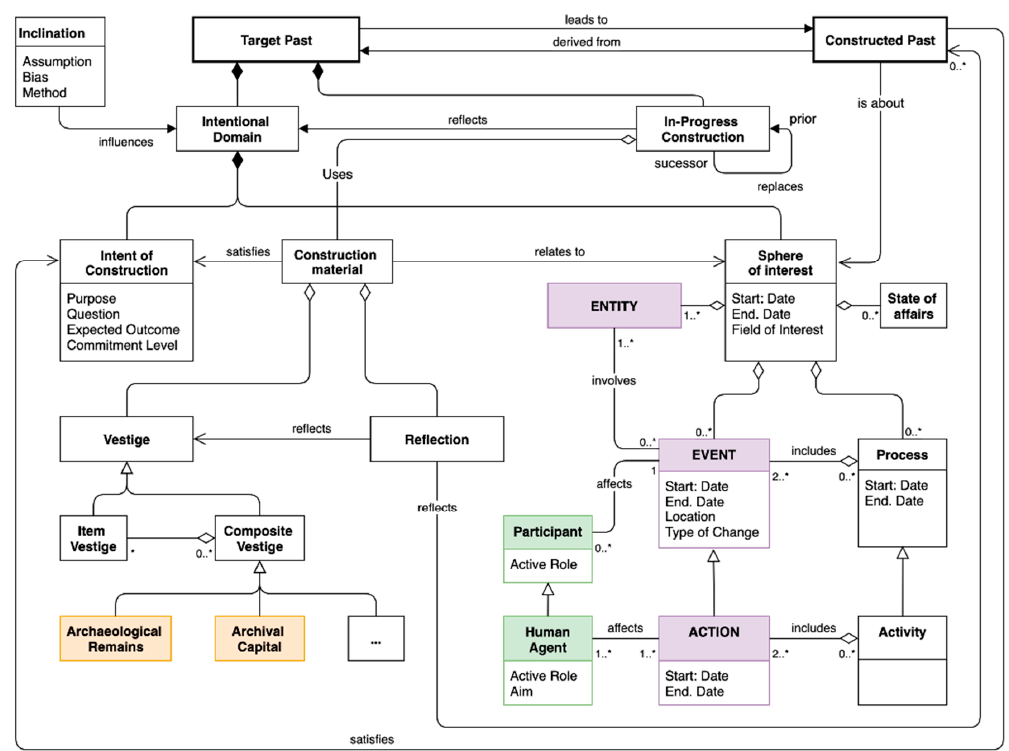
Figure 1. Summary view of Constructed Past Theory (CPT) according to K. Thibodeau [1] expressed as a UML diagram. Highlighted classes in purple and green are those related to our concepts of ‘Units of Topography’ and ‘Actors’, respectively, as further developed in our research domain. Extra detail will be provided in Section 3. Classes highlighted in orange are those in which these conceptual modeling has been applied.